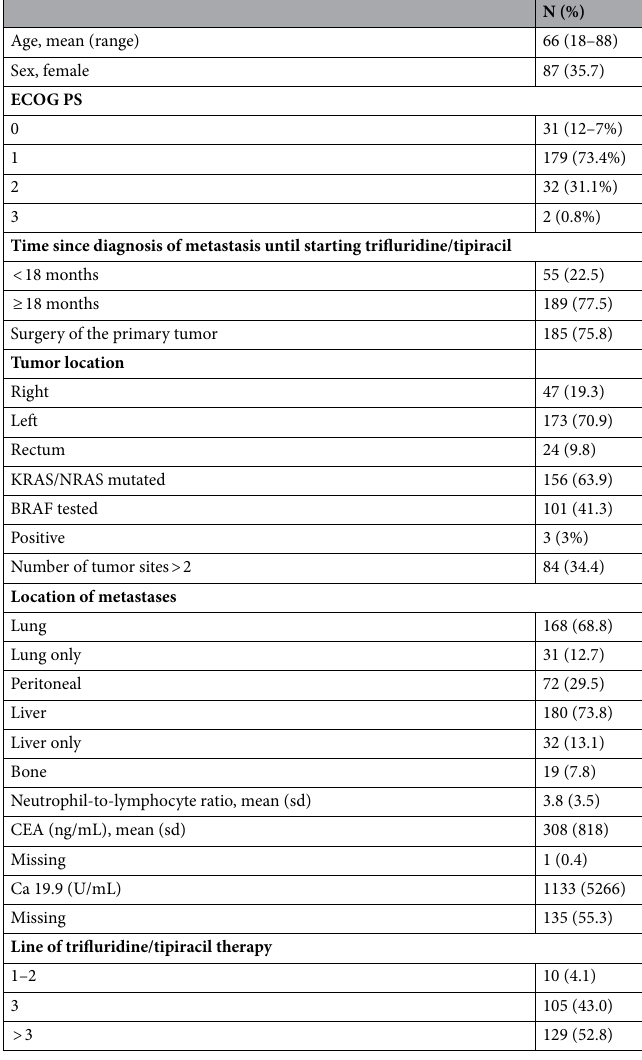
Table 1. Subjects received trifluridine/tipiracil following a median of 31.0 months (95% CI, 28.4–33.7) from the time of diagnosis of metastasis, and after progression to two or three previous lines (43.0% and 52.8%, respec-